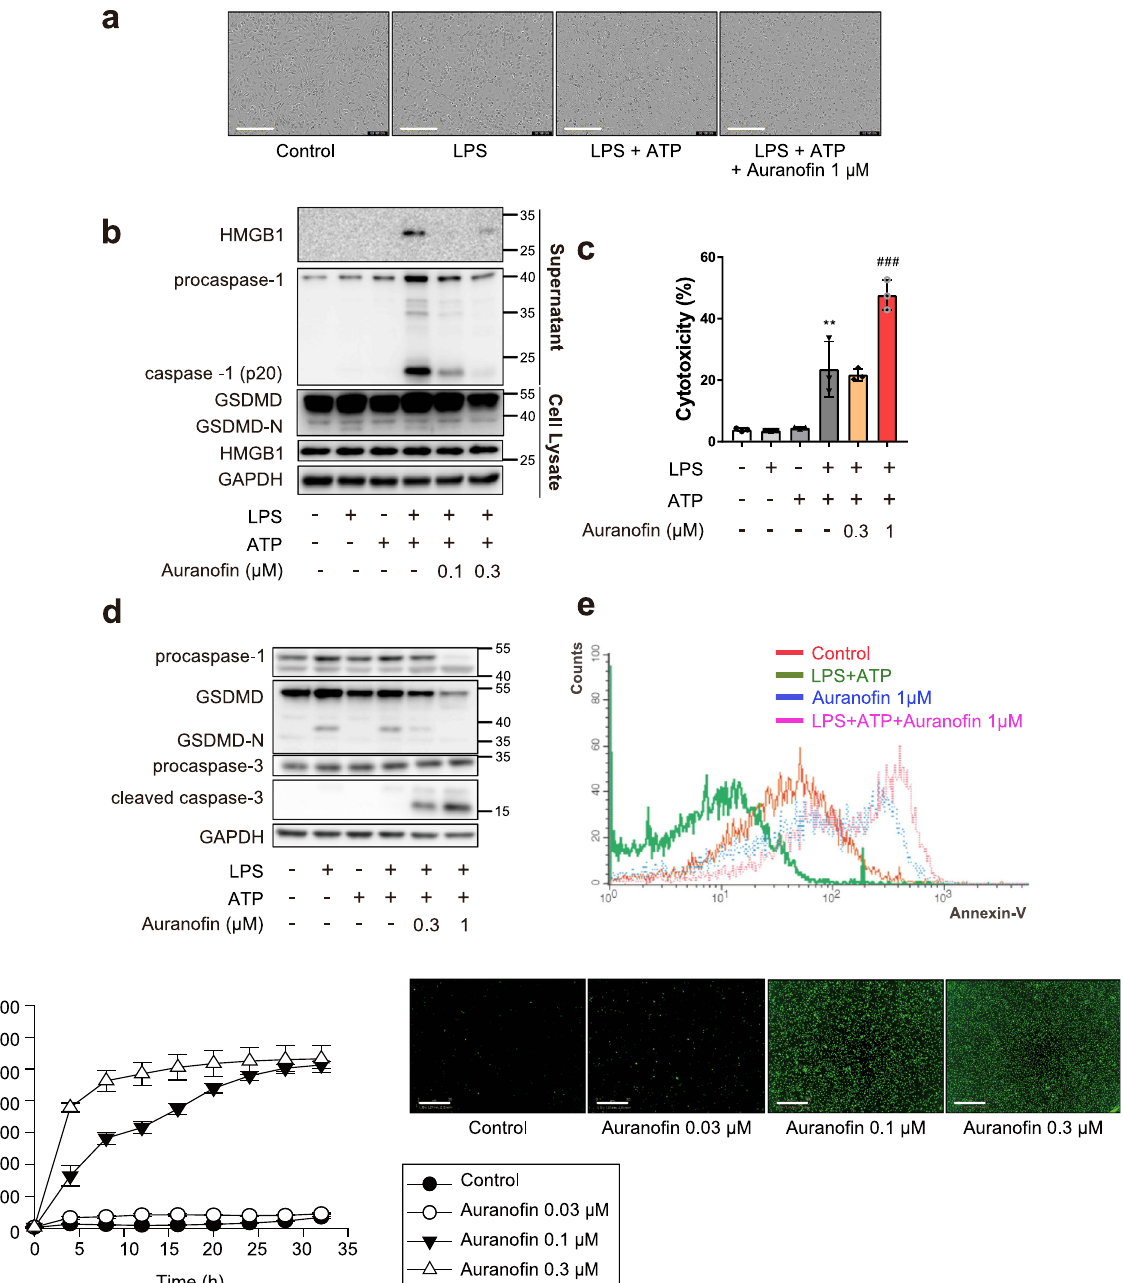
Fig. 3 Aurano fi n inhibits pyroptosis and induces apoptosis in macrophages. BMDMs were primed with LPS (100 ng/ml) for 4 h, followed by exposure to ATP (1 mM) and aurano fi n for 16 h. a Representative picture of LPS-primed BMDM treated with ATP (1 mM) and aurano fi n (1 µ M). Scale bar = 200 µ m. b Secretion of HMGB1 was determined by immunoblot analysis of supernatants. GSDMD-N was measured in cell lysates. c LDH assay was performed to evaluate cytotoxicity of aurano fi n on in fl ammasome-activated BMDM, n = 3. Data are presented as mean ± SD, analyzed by one-way ANOVA followed by Tuckey ’ s test; ** p < 0.01, compared to control; ### p < 0.001, compared to LPS, ATP-treated group. d Cleavage of caspase-3 and GSDMD-N were measured in cell lysates of BMDM primed with LPS followed by exposure of ATP (1 mM) and aurano fi n. e Annexin-V staining in the aurano fi n-treated BMDM. f Aurano fi n-treated BMDMs were stained using Incucyte ® caspase3/7 green reagent and detected using Incucyte ® ZOOM, n = 5. Data are presented as mean ± SEM. Scale bar = 300 µ